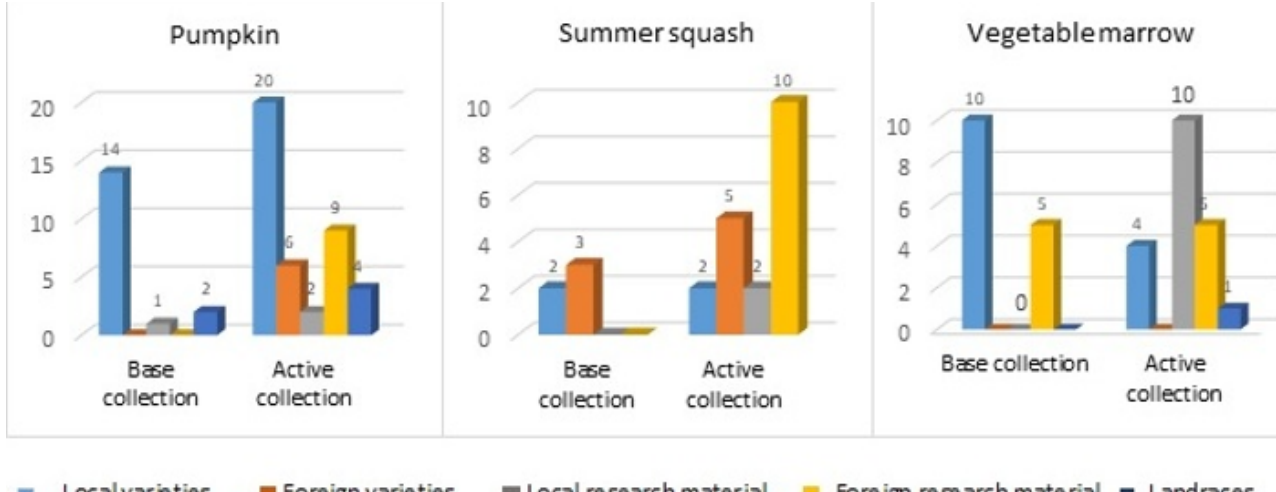
Figure 2. Numbers of accessions of local and foreign origin in base and active collections of pumpkin, summer squash and vegetable marrow at the Scientific Centre of Vegetable and Industrial Crops,